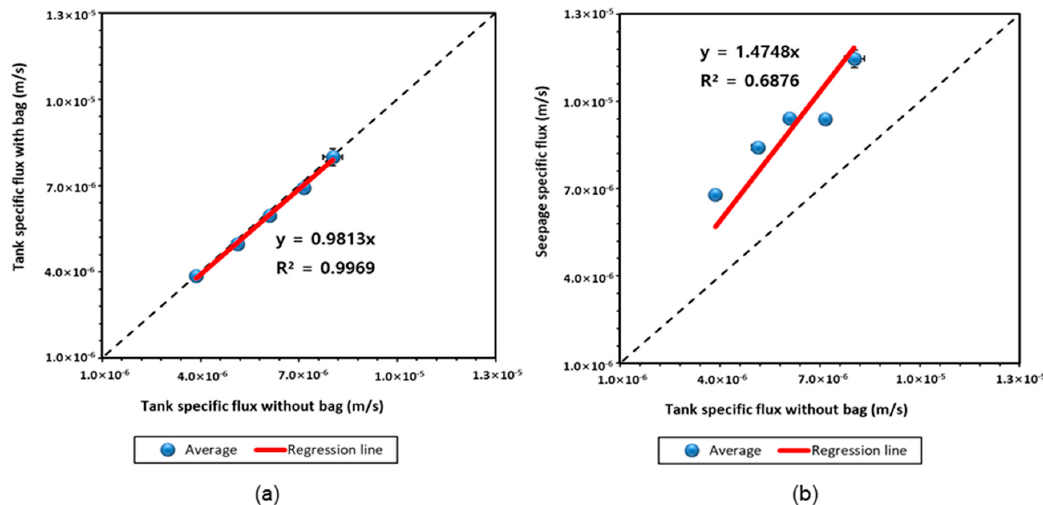
Figure 7. Comparison of ( a ) the tank specific outflux rates with and without the collection bag and ( b ) the tank specific outflux rate and the seepage specific outflux rate measured using the Type 2 collection bag. Error bars represent the standard deviations for eight experiments at each pumping rate (see Table 5).